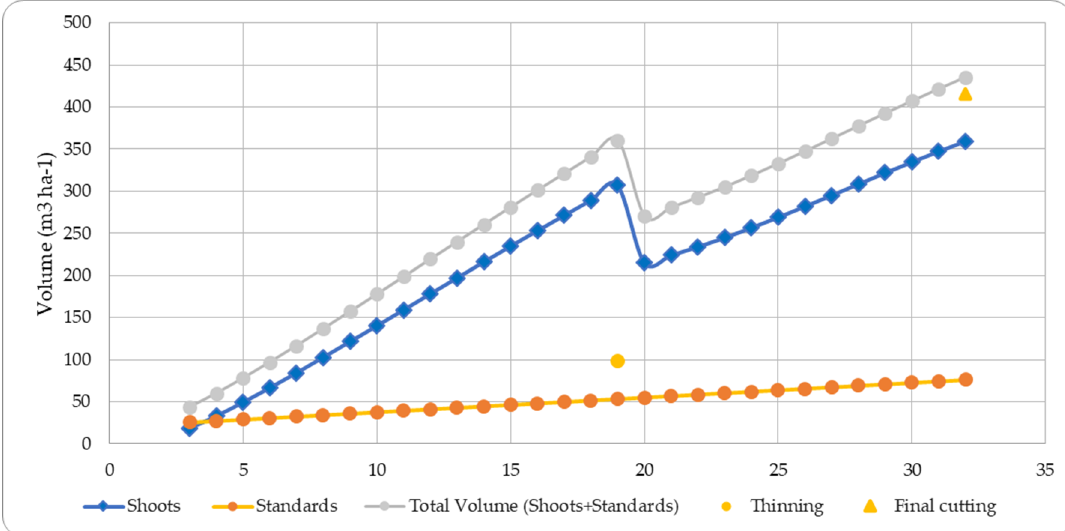
Figure 1. Chestnut growth and yield and wood fellings in the forest section considered in the case study.